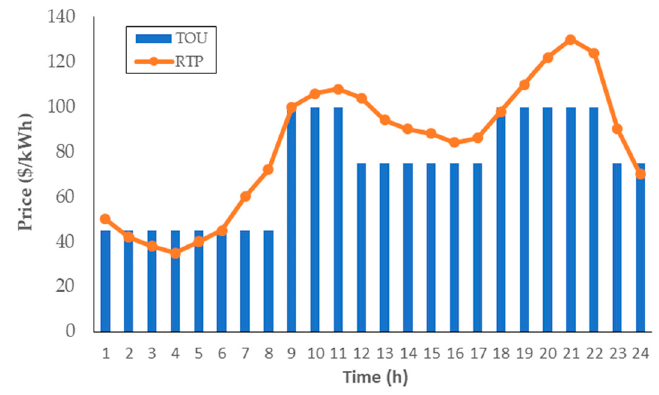
Figure 5. Market price information.